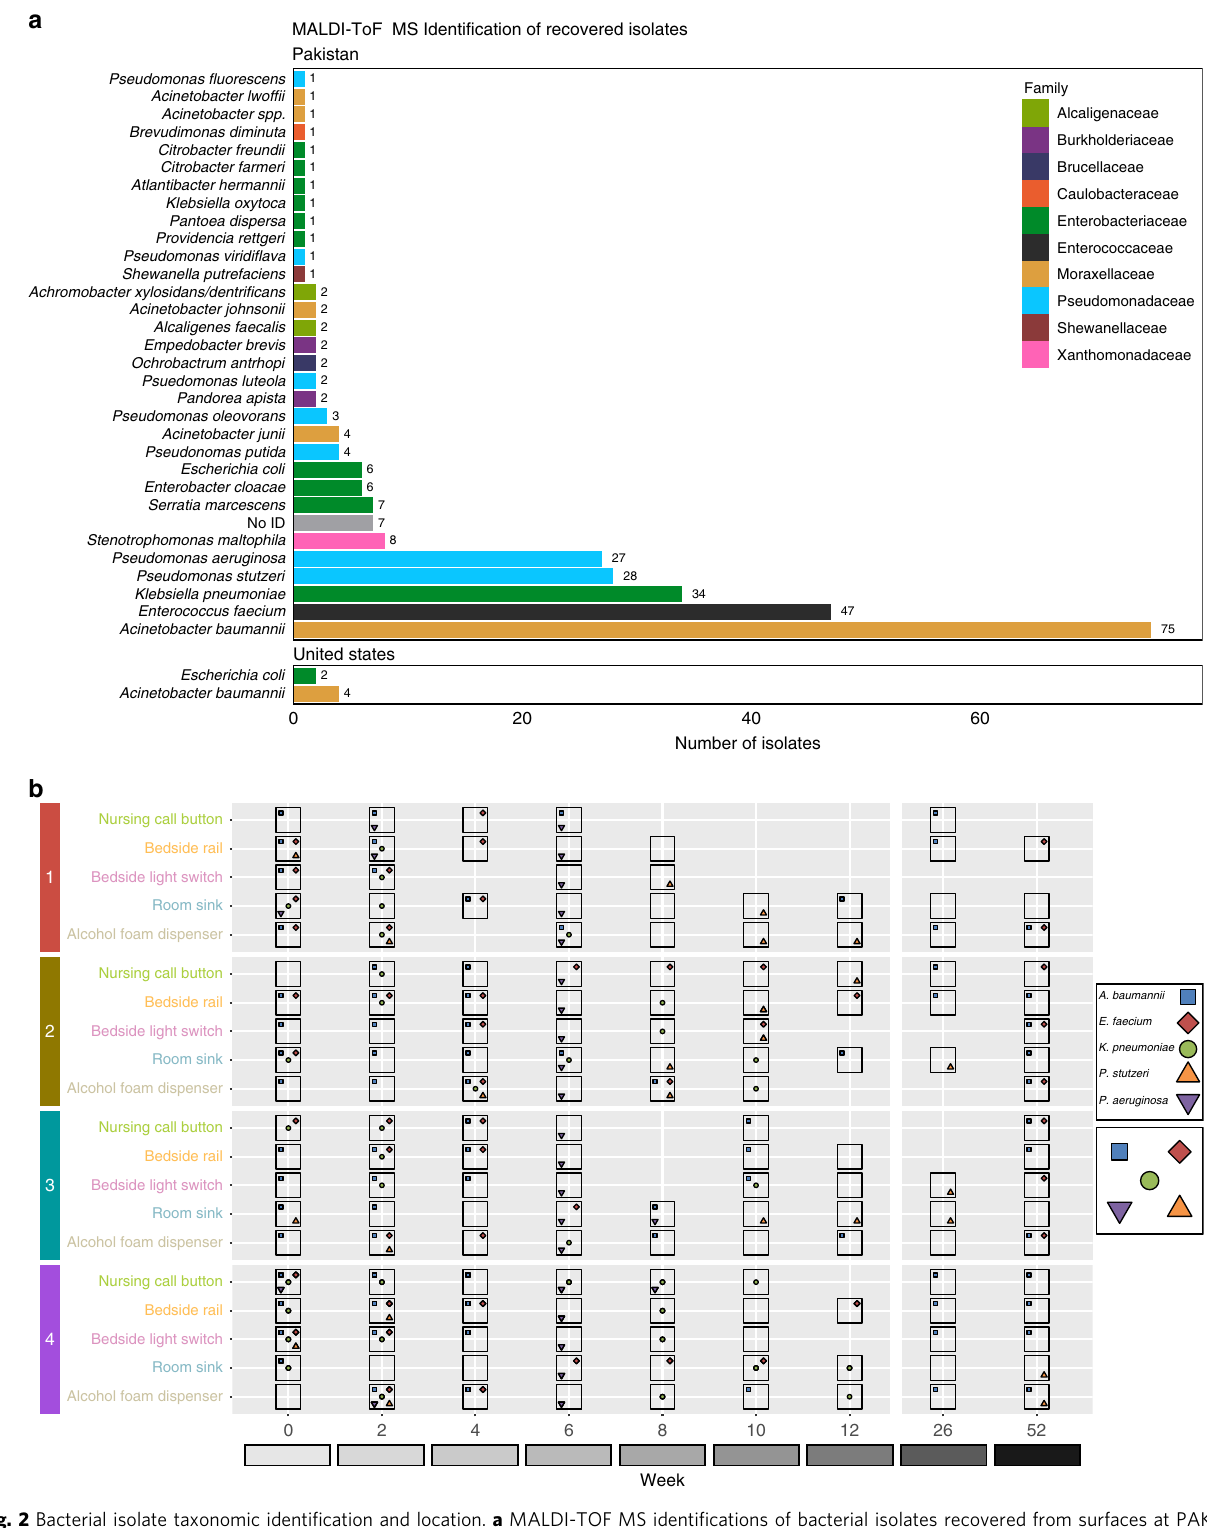
Fig. 2 Bacterial isolate taxonomic identi fi cation and location. a MALDI-TOF MS identi fi cations of bacterial isolates recovered from surfaces at PAK-H (above) and USA-H (below), colored by family. b Overview of PAK-H bacterial surface collections. Each horizontal gray panel represents a PAK-H room. Within each room, the horizontal gridded white lines are the fi ve sampled surfaces. Each vertical white line is one of the collection weeks. Places where the horizontal and vertical white lines intersect represent a sampling. Large, open black boxes are around any surface where one or more bacteria were collected. The fi ve most abundant species in the collections are indicated as colored shapes within the black boxes of surfaces where they were collected (blue squares are A. baumannii , red diamonds are E. faecium , green circles are K. pneumoniae , orange triangles are P. stutzeri , and purple triangles are P. aeruginosa ). Source data for both panels are provided in the source data fi